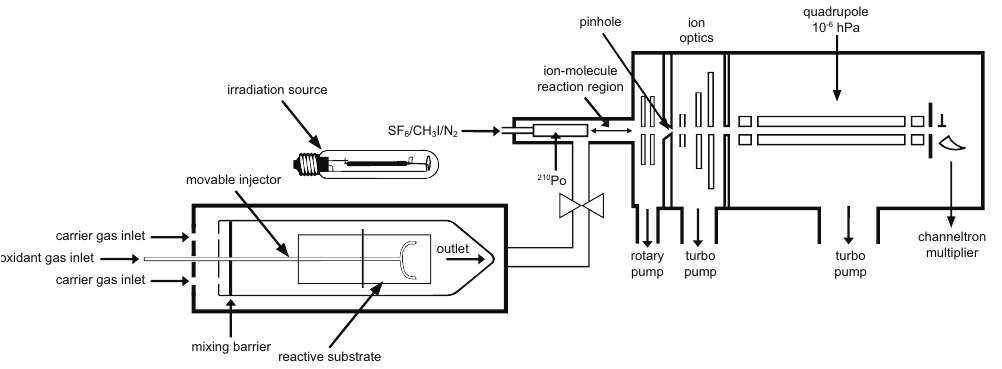
Fig. 1. Schematic representation (not to scale) of the irradiated rectangular channel flow reactor (I-RCFR) coupled to the chemical ionisation mass spectrometer. Irradiation source distance above the I-RCFR is